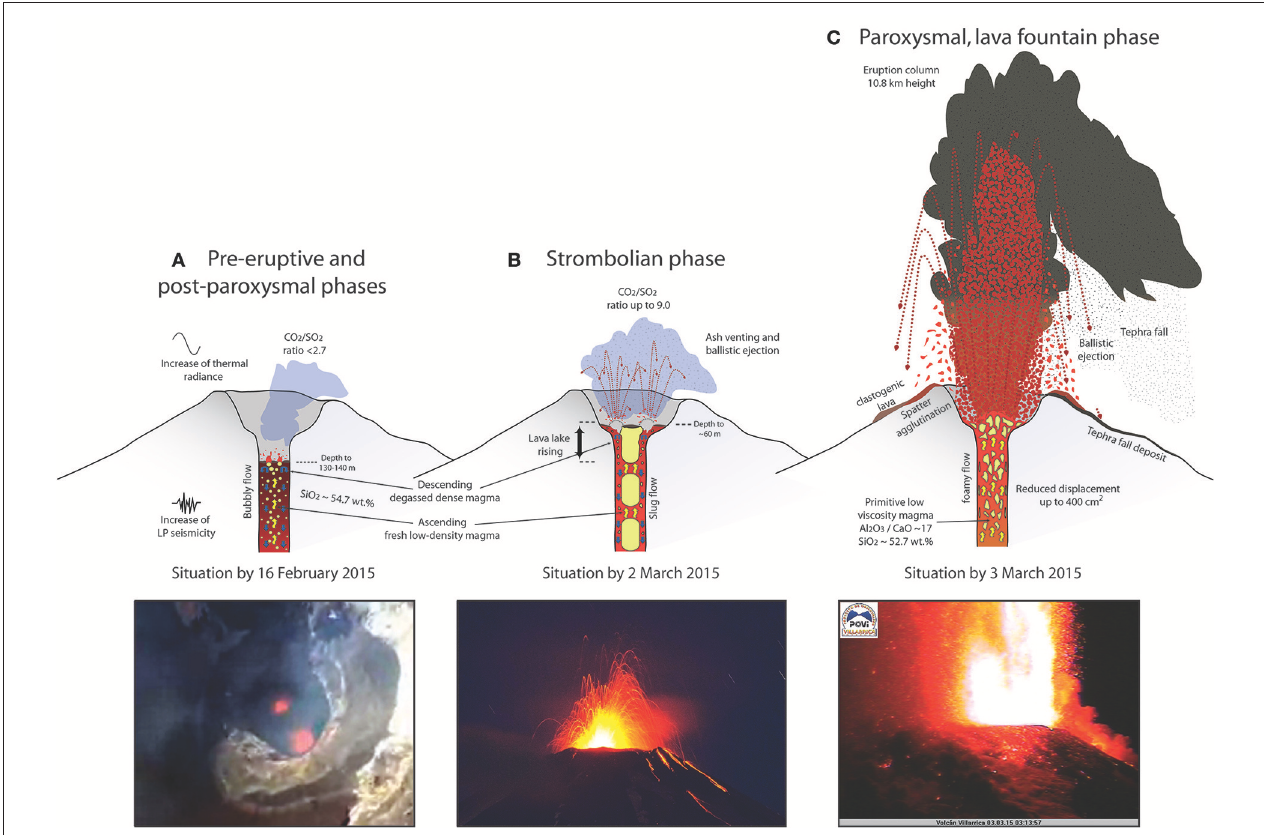
FIGURE 6 | Cartoon (not-to-scale) illustrating conduit dynamics in the shallow plumbing system of Villarrica Volcano between 16 February and 3 March 2015. Panel (A) shows convective magma dynamics with lava lake at depth of 130–140m below the crater rim (see Johnson et al., 2018). The rising of fresh (volatile-rich) low-density magma to the surface produces lava bursting at two small vents within the solidified crust of the lava lake. CO 2 /SO 2 ratios are low ( < 2.6; Aiuppa et al., 2017) while simultaneously LP seismicity and thermal radiance start to rise. Aerial picture of the vent by Isa Stemberga. (B) An increased supply of deep-sourced volatile-rich magma produces a slug flow within the eruptive conduit, which results in the rise of lava lake (up to 60m depth, Johnson et al., 2018), Strombolian activity and enriched CO 2 /SO 2 degassing by 2 February (Aiuppa et al., 2017). (C) The rise of a more primitive basaltic-andesite foamy magma is associated with the beginning of lava fountaining activity and sustained eruption column. Ballistic pyroclasts, lava spatter, and tephra are discharged together during paroxysmal activity. Mixed avalanche deposits are not included within this model as they are currently object of